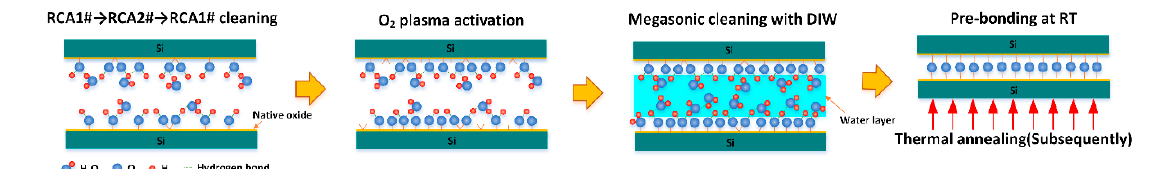
Figure 1. Schematic diagram of the O 2 plasma-activated direct bonding.